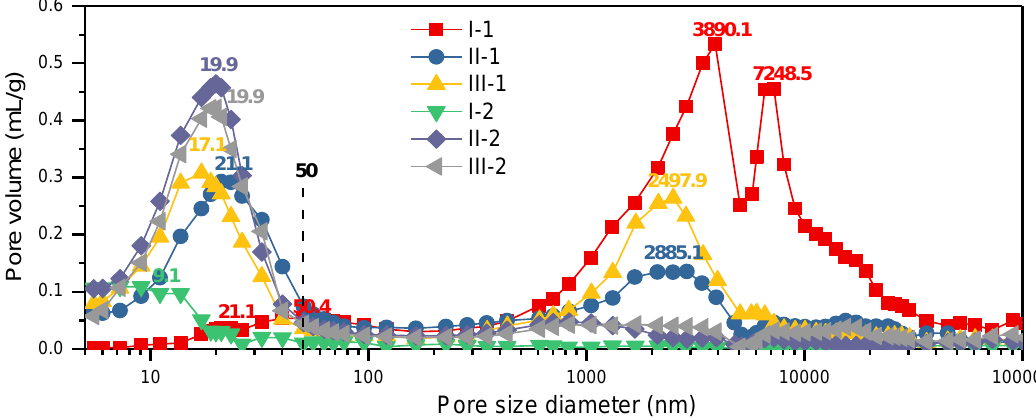
Figure 6. Pore size distributions of the LC